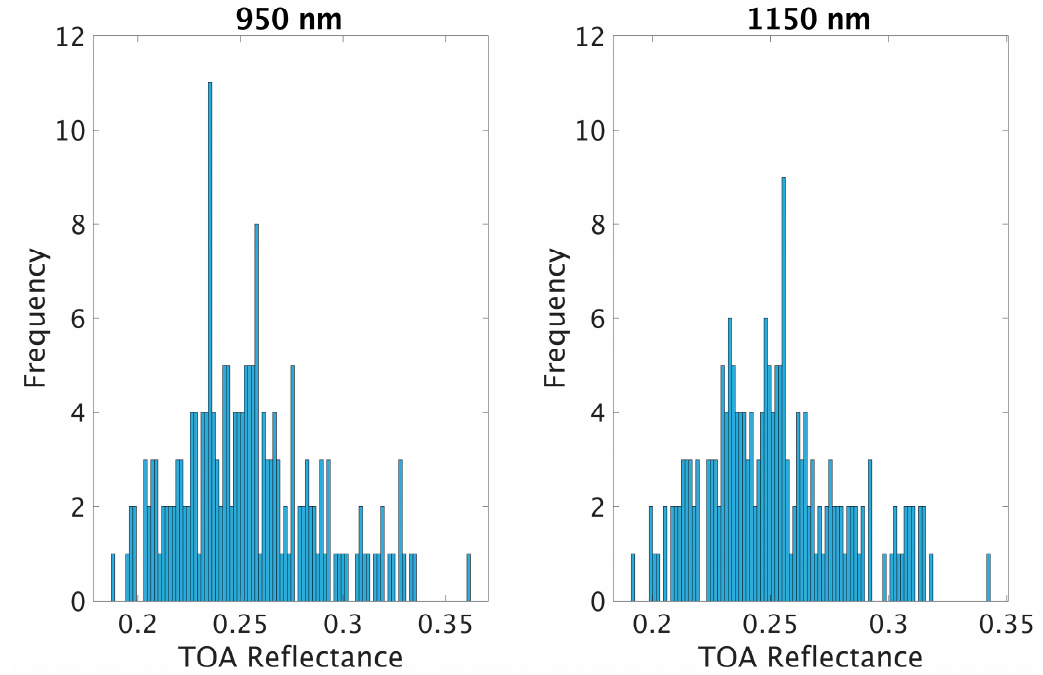
Figure 11. Range of TOA reflectance at absorptions wavelength, 950 nm (left) and 1150 nm (right).